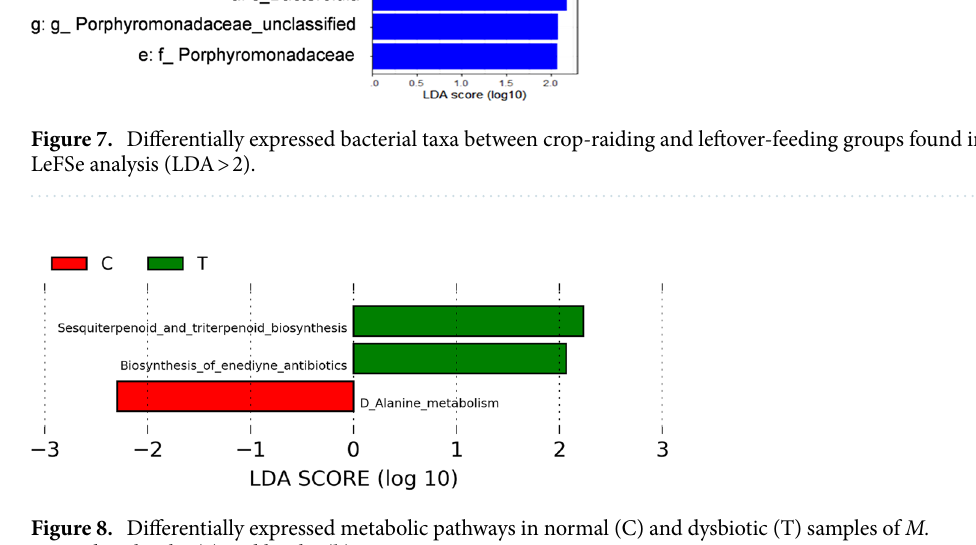
Figure 8. Differentially expressed metabolic pathways in normal (C) and dysbiotic (T) samples of M. munzala at level 2 ( a ) and level 3 ( b